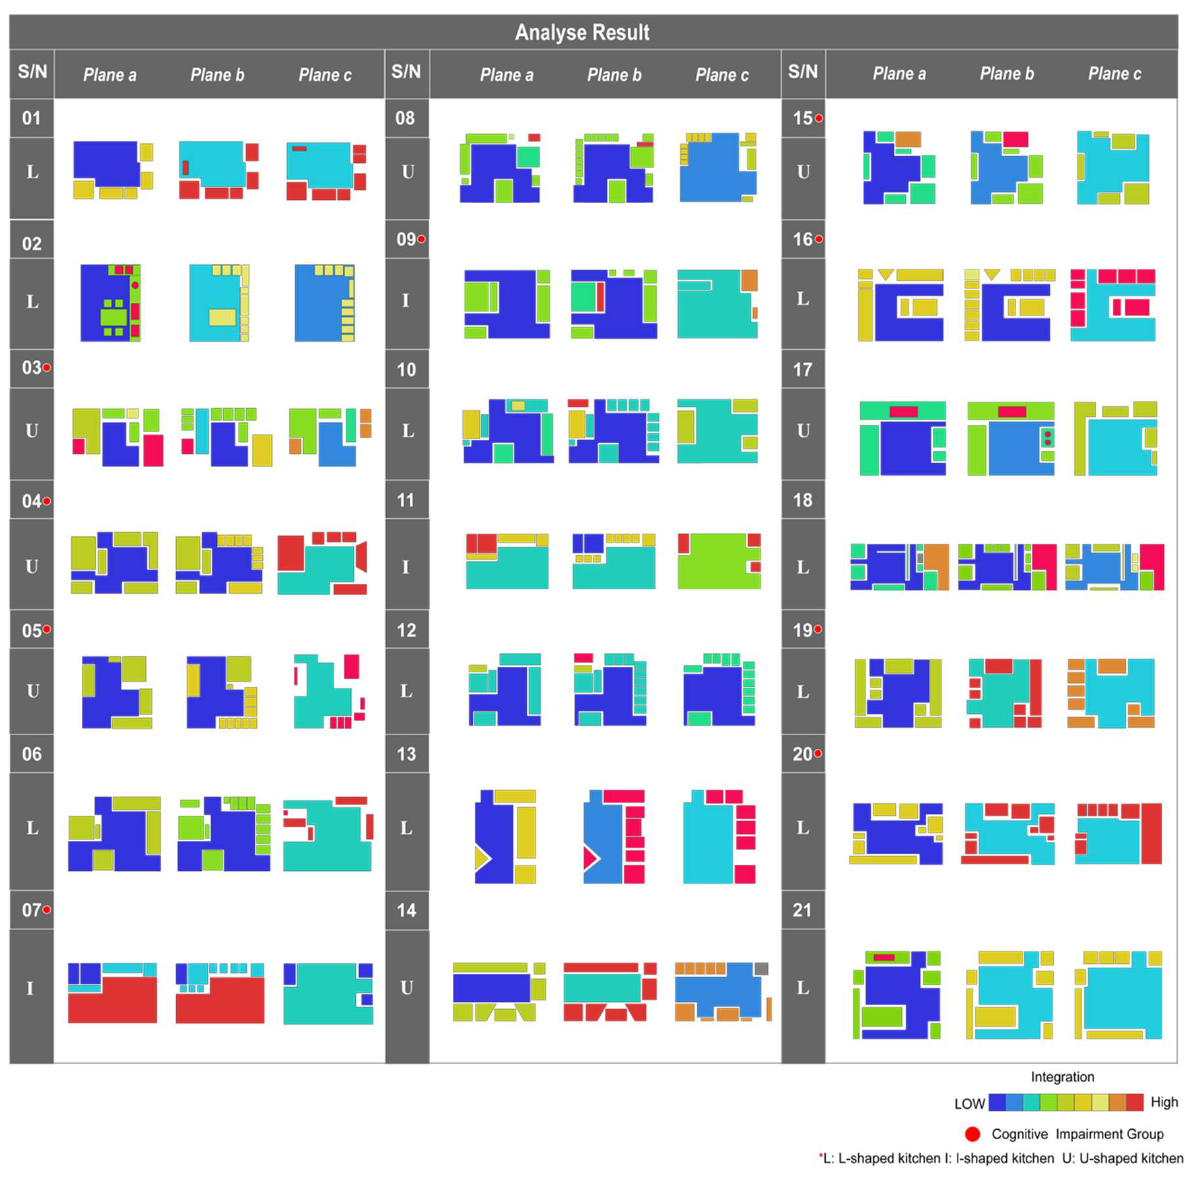
Figure 3. Kitchen sample space layout analysis.